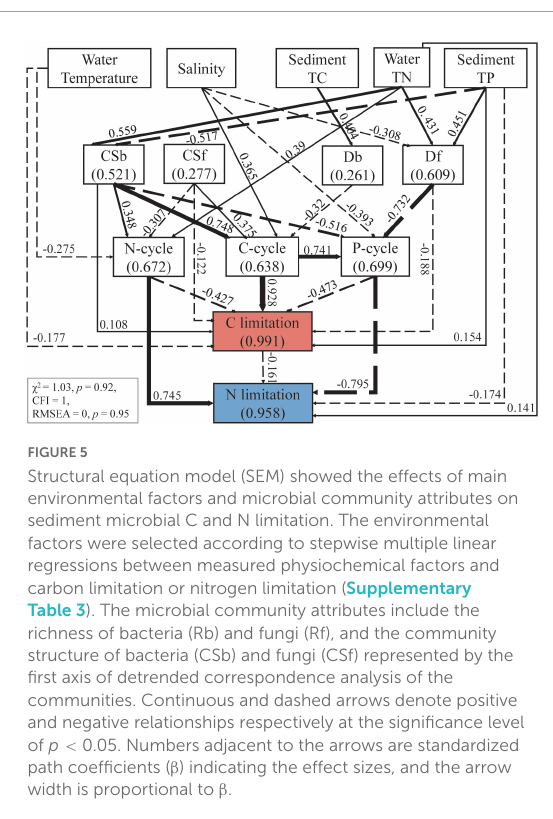
FIGURE5 Structural equation model (SEM) showed the effects of main environmental factors and microbial community attributes on sediment microbial C and N limitation. The environmental factors were selected according to stepwise multiple linear regressions between measured physiochemical factors and carbon limitation or nitrogen limitation ( Supplementary Table 3 ). The microbial community attributes include the richness of bacteria (Rb) and fungi (Rf), and the community structure of bacteria (CSb) and fungi (CSf) represented by the first axis of detrended correspondence analysis of the communities. Continuous and dashed arrows denote positive and negative relationships respectively at the significance level of p < 0.05. Numbers adjacent to the arrows are standardized path coefficients ( β ) indicating the effect sizes, and the arrow width is proportional to β .